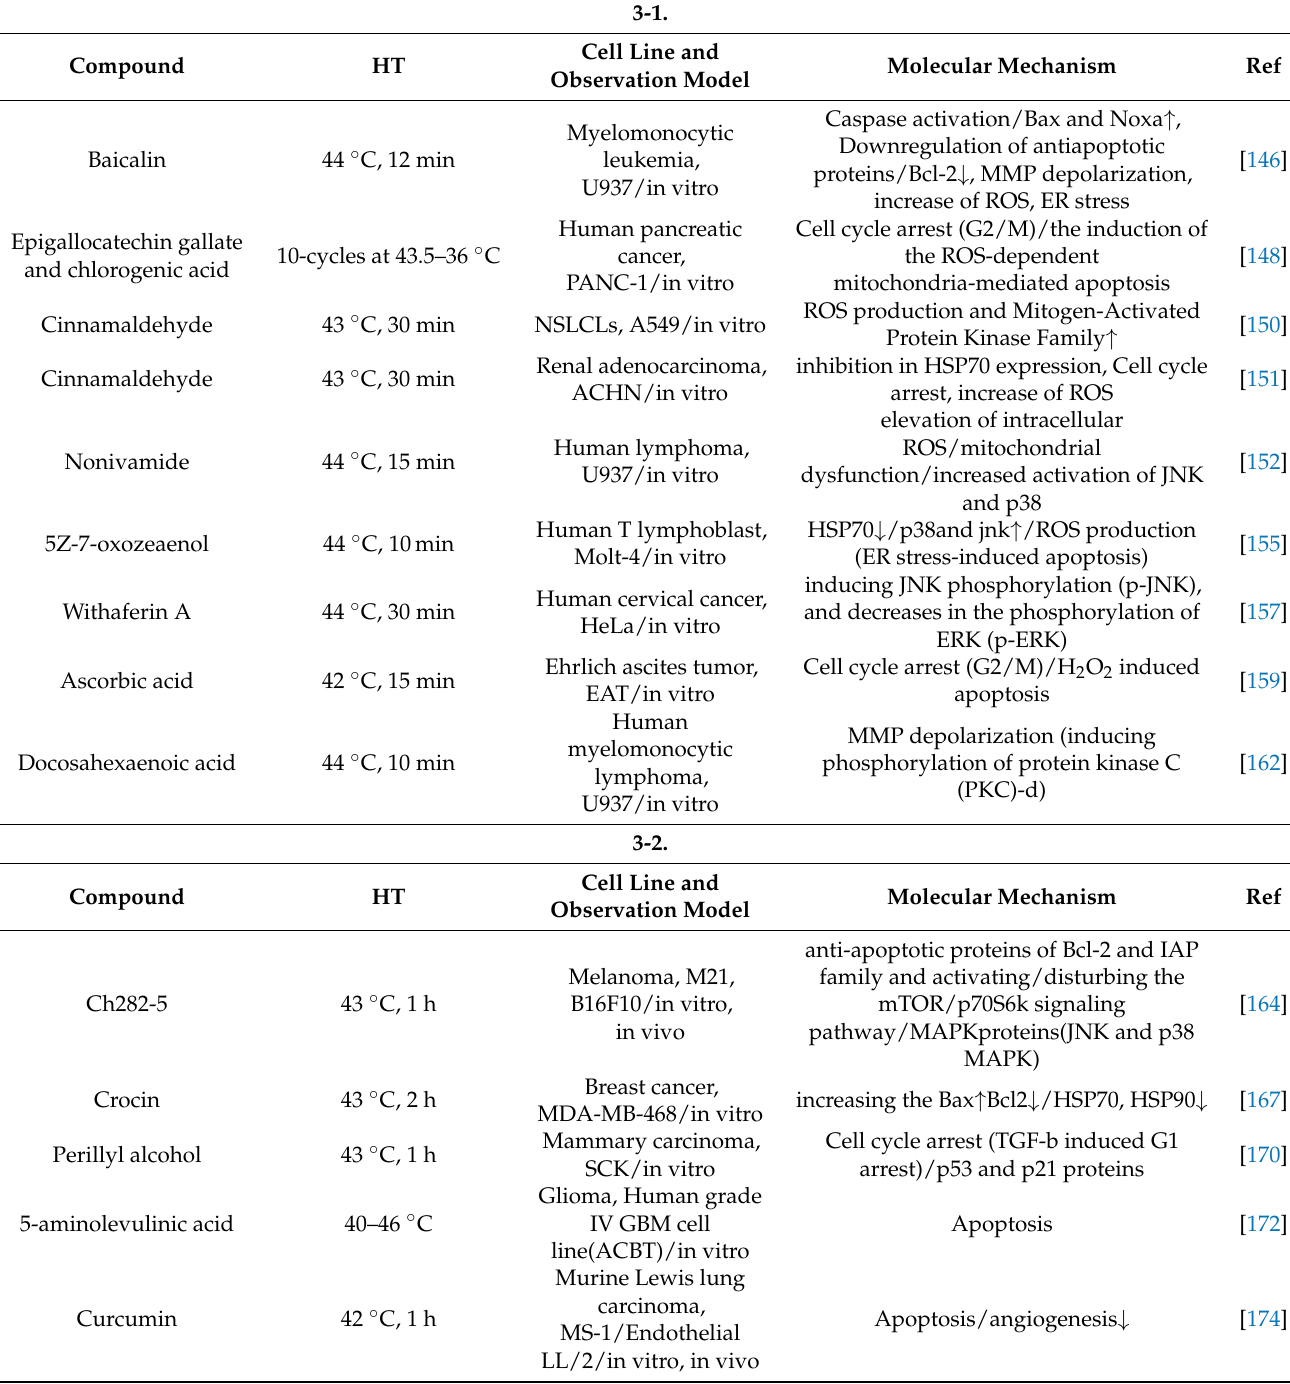
Table 3. 3-1. HT + natural products (ROS production). 3-2. HT + natural products (Regulation